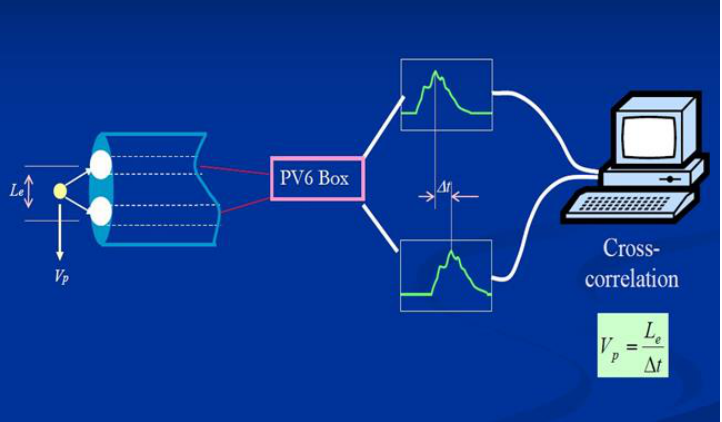
Figure 8. Schematic Representation of the Cross-Correlation Analysis for Obtaining Solids Velocity Using an Optical Probe.